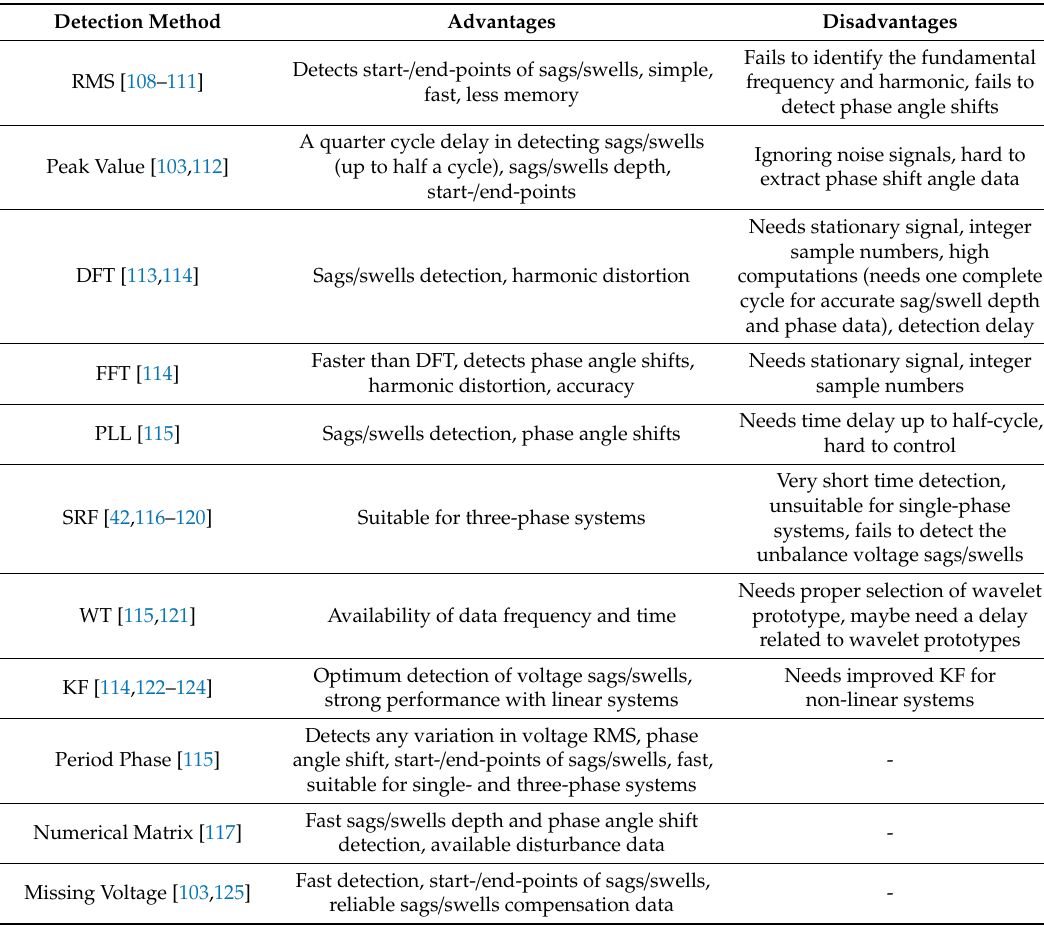
Table 7. Voltage disturbance detection methods, their advantages, and